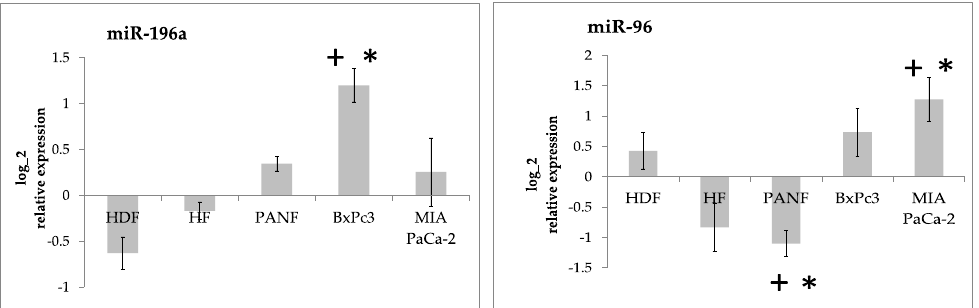
Figure 3. Downregulation of miR-217 in cultured human fibroblasts (HDF and HFs), pancreatic- ductal-cancer-associated fibroblasts (PANF), and PDAC cell lines (BxPC3 and MIA PaCa-2) compared to the tissue of the normal pancreas. Significant differences between cultured cells and the tissue of the normal pancreas, i.e., two-fold decrease at adjusted p -value < 0.05, are marked by asterisks. Statistically significant differences between HDF of ectomesenchymal origin and other cell lines at adjusted p -value < 0.05 are marked by crosses.